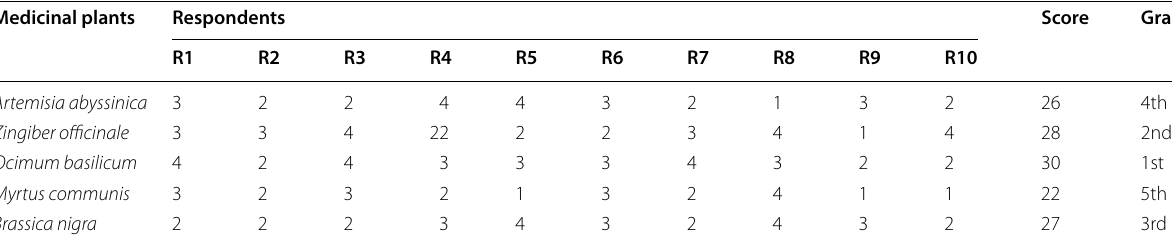
Table 8 Paired comparison on medicinal plants Medicinal plants Respondents